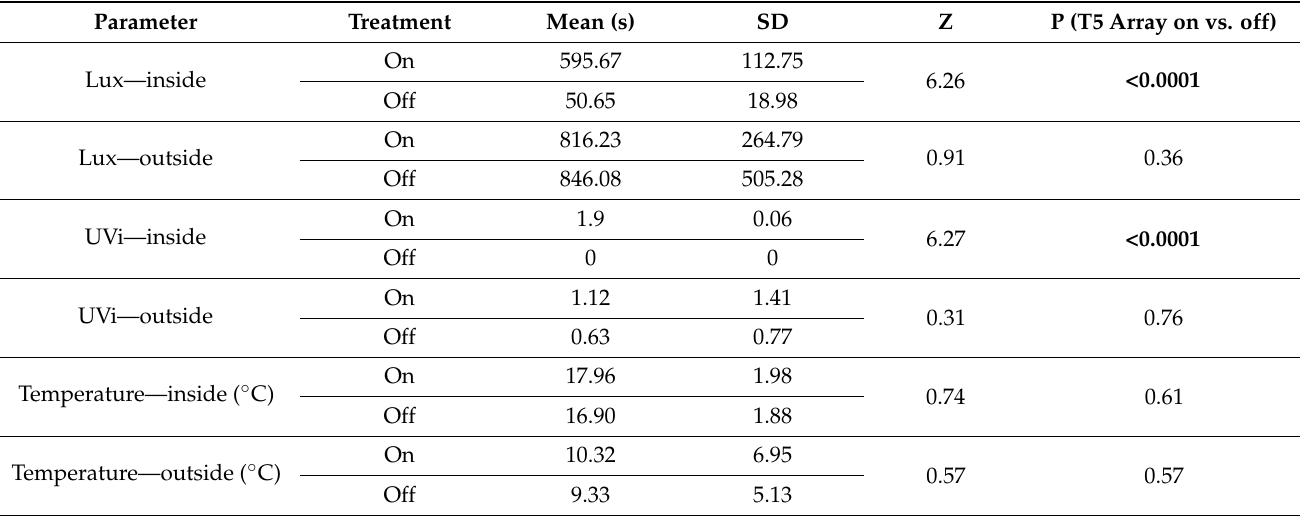
Table 1. Environmental parameter means and associated standard deviations in and outdoors, under T5 on and off treatments, along with Z scores and p values from Mann–Whitney U Tests comparing treatments for each parameter. Significant p values are in